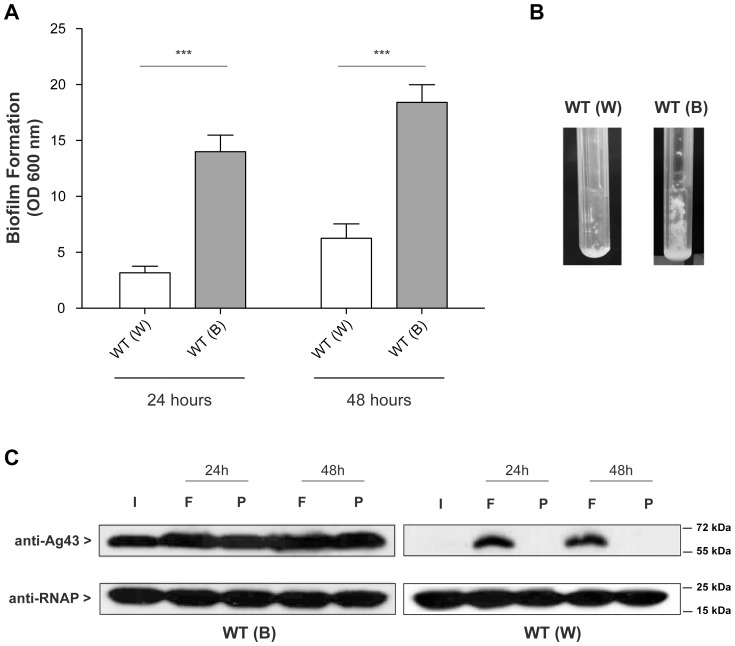

In vitro biofilm produced in continuous flow culture bioreactors selects for agn43 ON cells.
A. Biofilms of TG agn43-lacZ from an ON or an OFF colony in microfermentors. The biofilms were grown for 24 and 48 h; the biomass growing on the spatula was resuspended in 10 mL M63B1Gluc and the optical density at 600 nm was measured. (B): ON colony, (W): OFF colony; B. Pictures of microfermentors after 48 h growth. ***: p<0.0001. C. Immunodetection of Ag43 in TG agn43-lacZ biofilm (F) or planktonic cultures (P) from ON (B) or OFF (W) colonies. I: inoculum, F: microfermentor biofilm, P: planktonic culture, the α-subunit of RNA polymerase (RNAP) was used as an internal control.